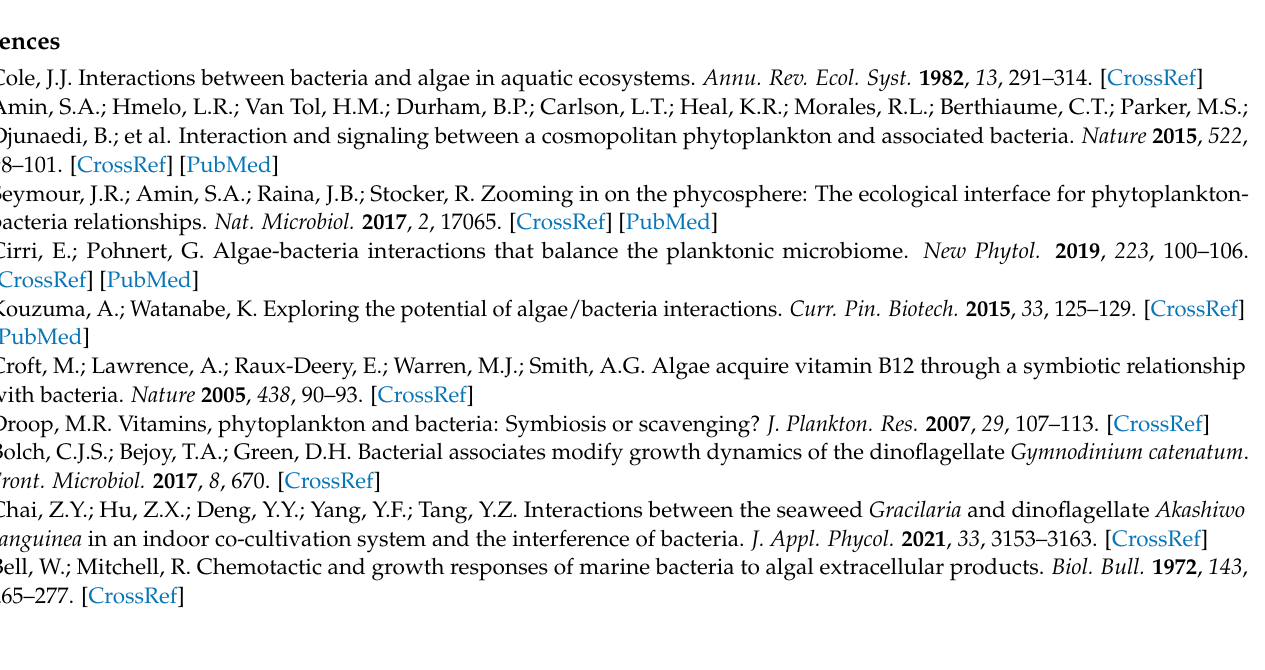
Figure S2. Phylogram tree of the generated bacterial features at genus level. Figure S3. Heatmap analysis of bacterial communities based on top 30 most abundant features at phylum level (a) and genus level (b). Figure S4. Bar plot of significantly different bacterial phyla (a) and genera (b) between DINO and N-DINO groups. Figure S5. Prediction of the differential function of bacterial communities between DINO and N-DINO groups in KO assignments. Figure S6. Bar plot of significantly different bacterial genera between Thecate and Athecate groups. Figure S7. Alpha and beta diversity analysis between Thecate and Athecate groups. Figure S8. Prediction of the differential function of bacterial communities between Thecate and Athecate groups in KO assignments. Figure S9. Alpha and beta diversity analysis between Anti and N-Anti groups. Figure S10. Bubble plot for top 31 significantly different bacterial genera between Anti and N-Anti